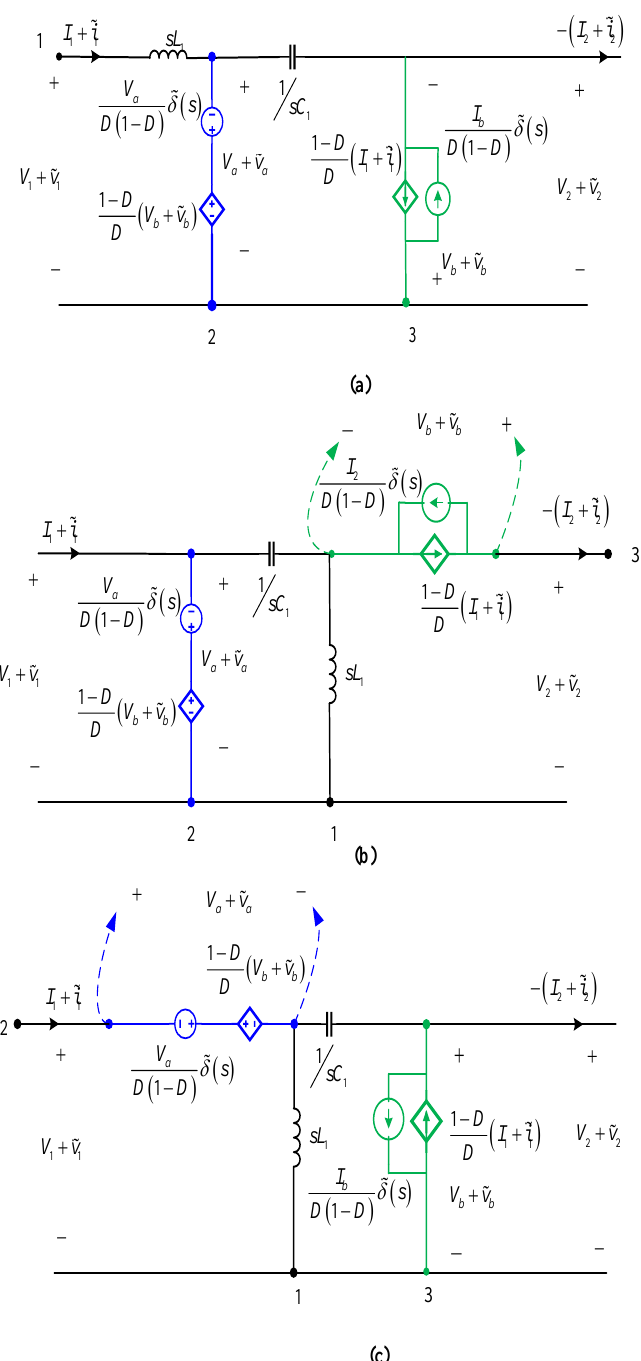
Figure 7. Rail connection variants for the lumped Type 2 BBBs. ( a ) Switch and diode to rail, ( b ) Inductor and switch to rail, and ( c ) inductor and diode to rail .